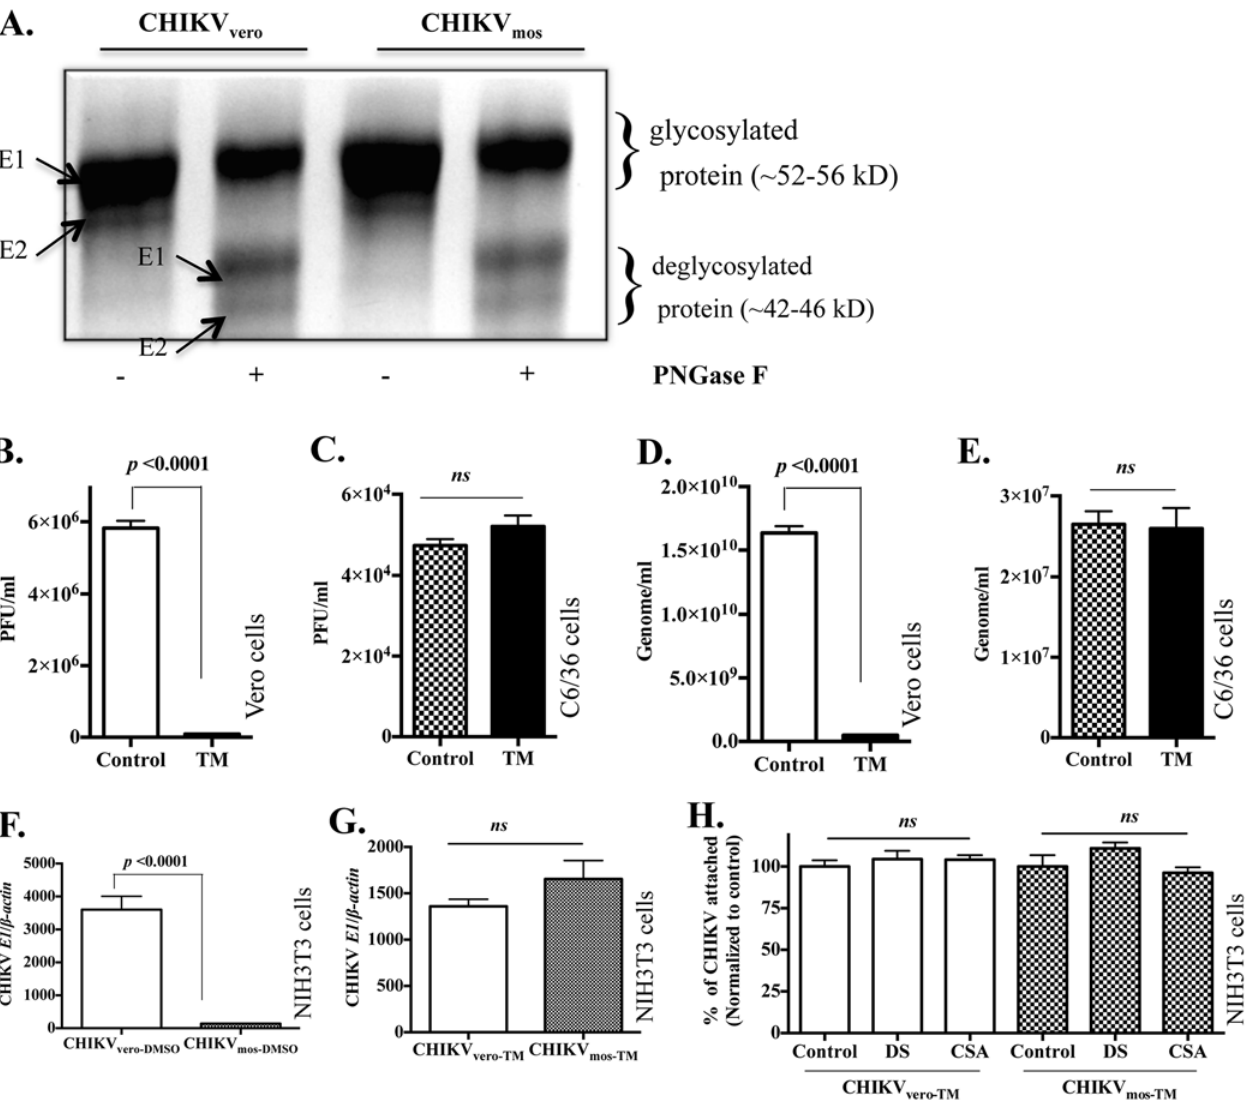
Fig 8. Mosquito cell-specific glycosylation reduces CHIKV infectivity. (A) SDS-PAGE image for CHIKV vero and CHIKV mos proteins that were treated with PNGase F to remove N-glycans from viral glycoproteins. (B-E) Vero cells or C6/36 cells were infected for 20 h with parental stocks of CHIKV (Ross) in the presence of tunicamycin (TM, 0.1 μ g/ml), or with dimethyl sulfoxide (DMSO) as vehicle controls to measure infectious virus particles released in culture media by plaque-forming assay (B and C) and the viral genome copies in the culture media by RT-qPCR (D and E). NIH3T3 cells were infected with 0.1 MOI of CHIKV vero-DMSO and CHIKV mos-DMSO (F), or CHIKV vero-TM and CHIKV mos-TM (G), and viral replication was measured at 24 h by RT-qPCR. (H) GAGs neutralization of CHIKV vero-TM and CHIKV mos-TM binding was performed with chondroitin sulfate A (CSA, 500 μ g/mL) and dermatan sulfate (DS, 500 μ g/mL) in NIH3T3 cells, and the attached viruses were quantified by RT-qPCR. A two-tailed student ’ s t-test was used for statistical analysis. Error bars indicate mean ± SEM. ns denotes not significant ( p (cid:1)